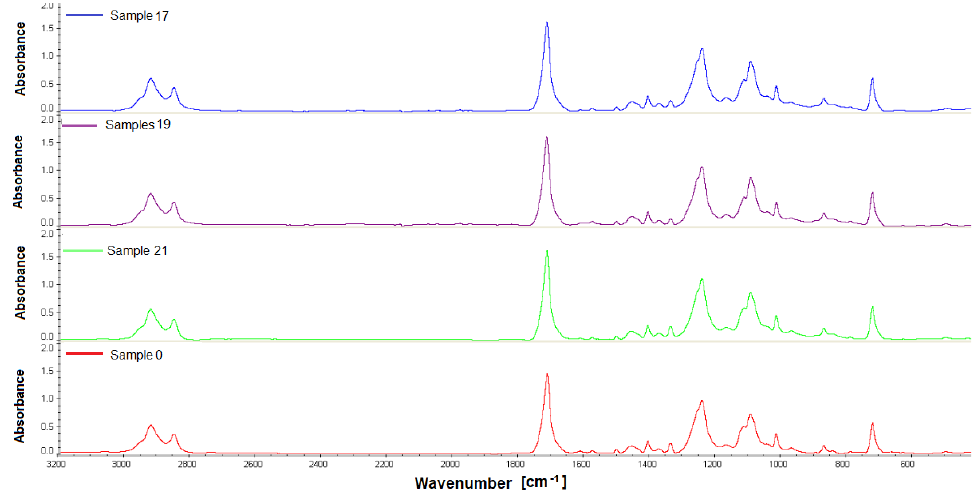
Figure 8. FTIR spectra of the studied PET-DLA 65 copolymers: sample 0-not implanted, sample 17, 19, 21 after 12-week implantation period.